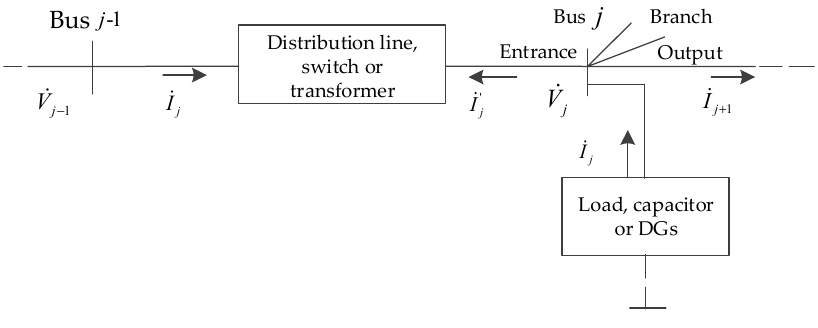
Figure 1. Basic elements in distribution network.